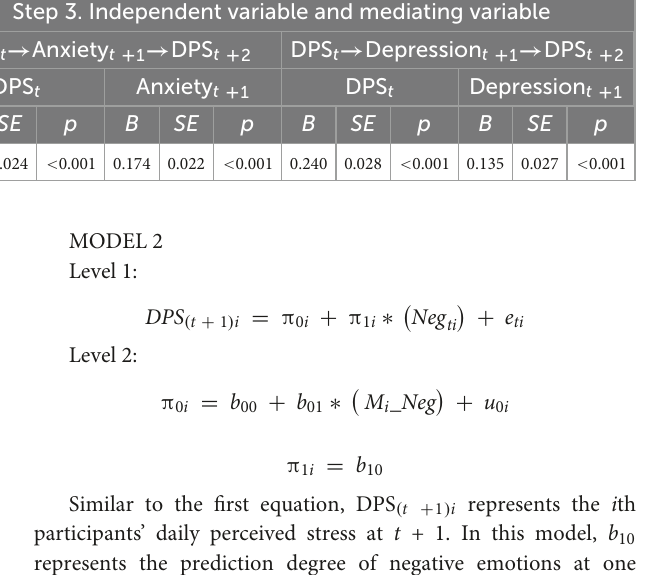
TABLE 4 Step 1 and Step 3 in mediating analysis of DPS t , Anxiety t + 1 , and DPS t + 2 and mediating analysis of DPS t , Depression t + 1 , and DPS t + 2 . Dependent variable Step 1. Independent variable Step 3. Independent variable and mediating